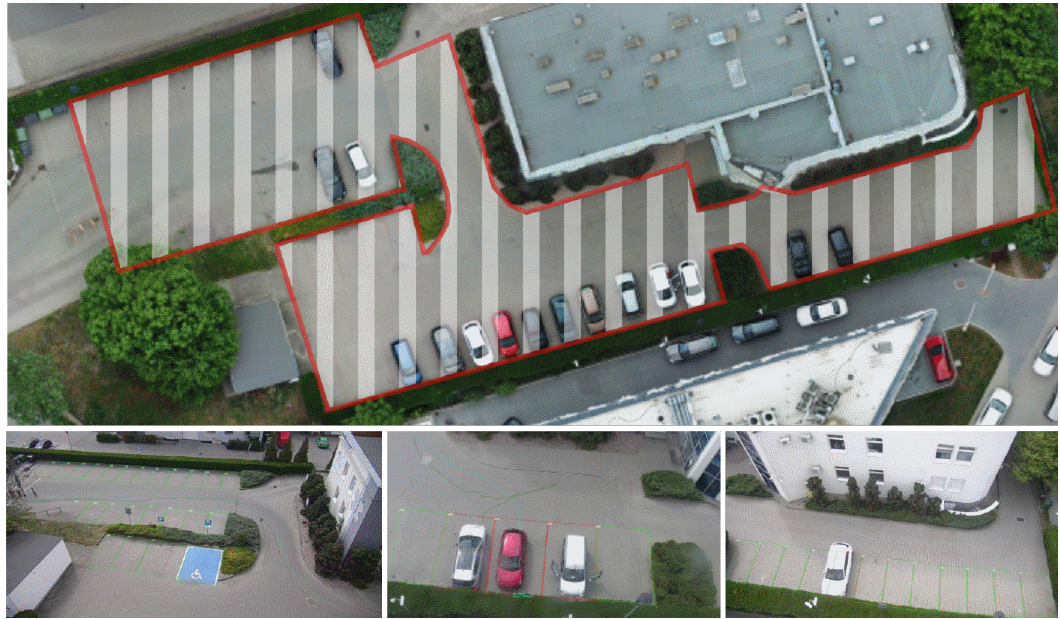
Figure 8. Simple multi-camera tracking system for a parking. The cameras track the vehicles from the barrier to the parking